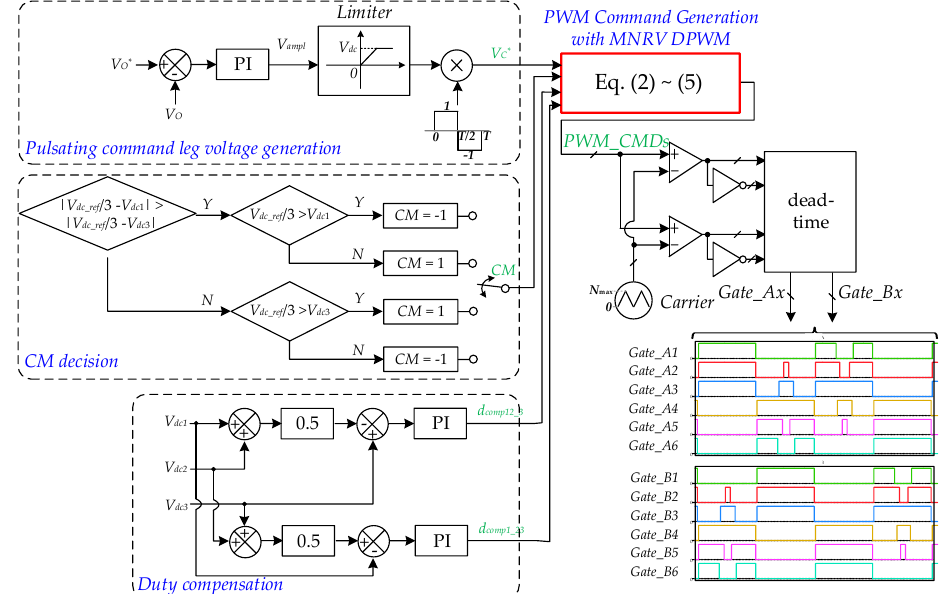
Figure 6. Control block diagram for the proposed converter.